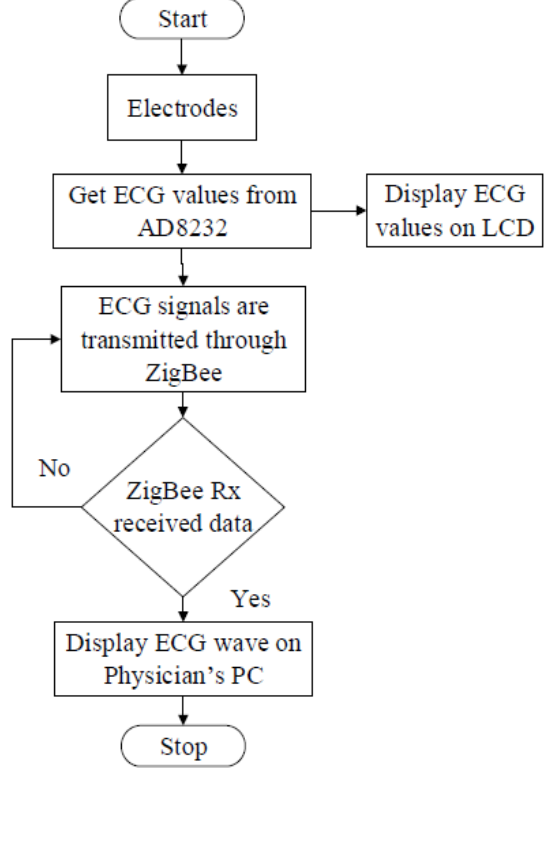
Figure 3. Flow Chart of portable ECG monitoring system